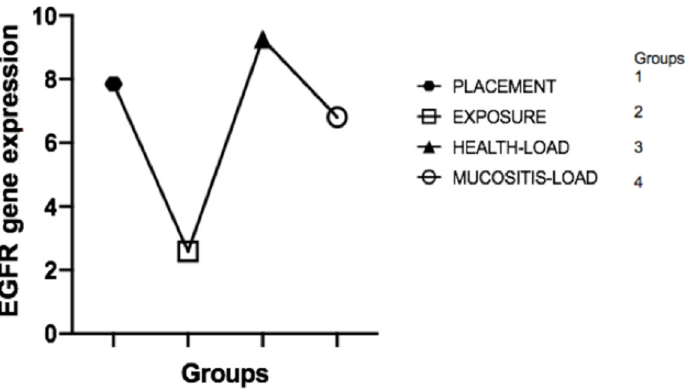
Figure 4. EGFR gene expression in groups 1, 2, 3, and 4, showing no statistical difference.